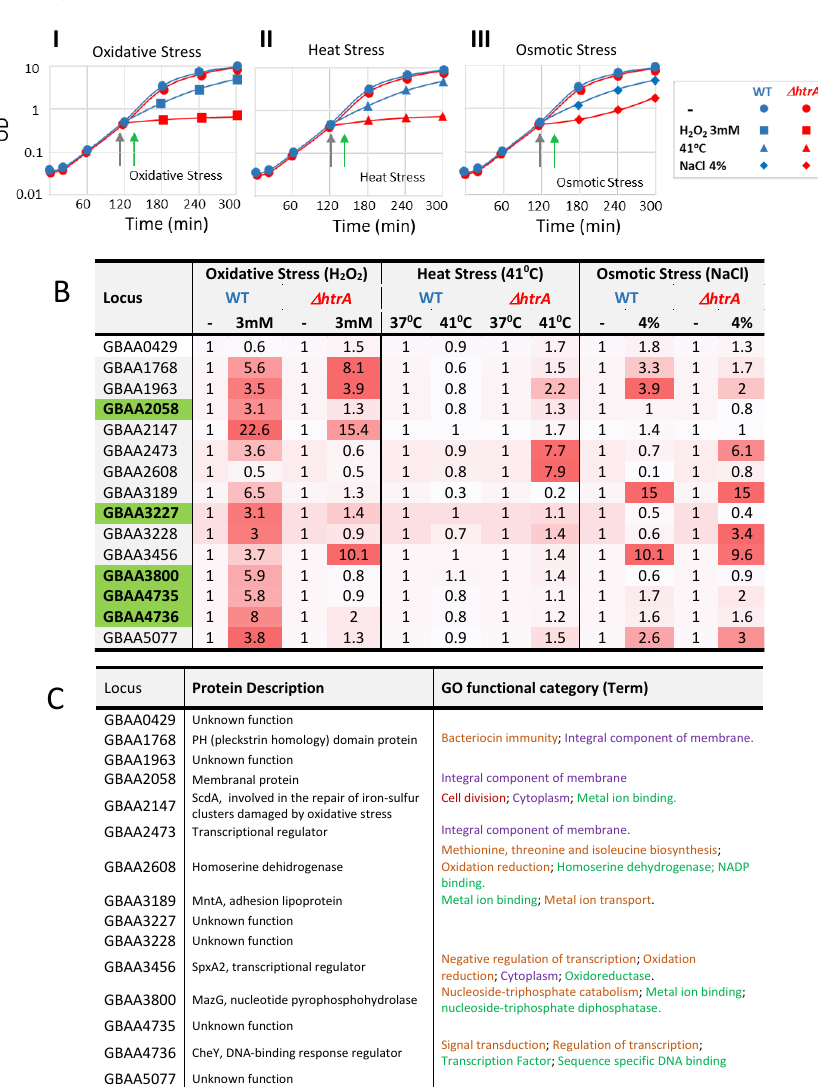
Figure 5. RT-PCR analysis of the transcription level of 15 Class II genes following oxidative, heat, and osmotic stress. ( A ) Growth profile of the WT (blue curves) and ∆ htrA (red curves) strains in the presence or absence of 3 mM H 2 O 2 (graph I), 41 ◦ C (graph II), or 4%NaCl (graph III). Growth curves in the absence of stress at 37 ◦ C are indicated by circles, in the presence of H 2 O 2 by squares, at 41 ◦ C by triangles, and in the presence of NaCl by diamonds. Gray arrows indicate the time of culture splitting into treated and untreated groups. Green arrows indicate the time of cell collection for RNA preparation. ( B ) Fold-change of 15 individual genes (indicated by their NCBI locus tag, on the left column) following the 3 stress regimens in either one of the strains. The transcription level in the absence of stress regimen was considered as 1 and that following stress treatment indicate the fold-change. Red gradient backgrounds indicate the extent of upregulation. Green background of locus tags indicates genes upregulated only upon H 2 O 2 treatment and only in the WT strain. ( C ) Functional annotations of the proteins encoded by the 15 selected genes. The colors of the GO functional categories indicate the GO division (root) to which they belong: biological processes (in brown), molecular function (green), and cellular component